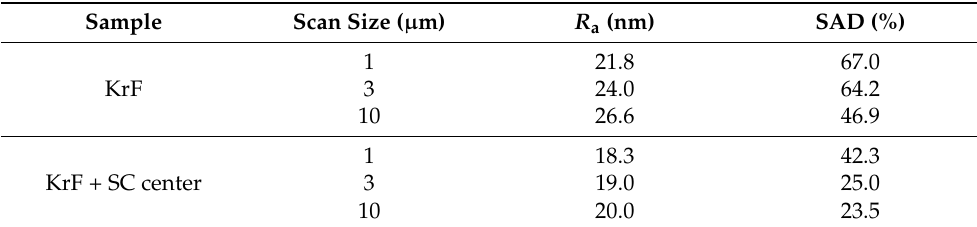
Figure 5. Two-dimensional and three-dimensional AFM scans of PET ( A ) and PEEK ( B ) surfaces with optomechanically processed AgNPs (KrF laser) after their irradiation with SC laser. Images show the center of SC-irradiated area, scan sizes of 1, 3 and 10 µ m. Table 3. AFM analysis parameters: average surface roughness (Ra) and surface area difference (SAD) for PEEK/AgNPs before (PEEK/AgNPs) and after (PEEK/AgNPs + SC) 408 nm semiconductor (SC) laser irradiation. Parameters correspond to Figures 3B and